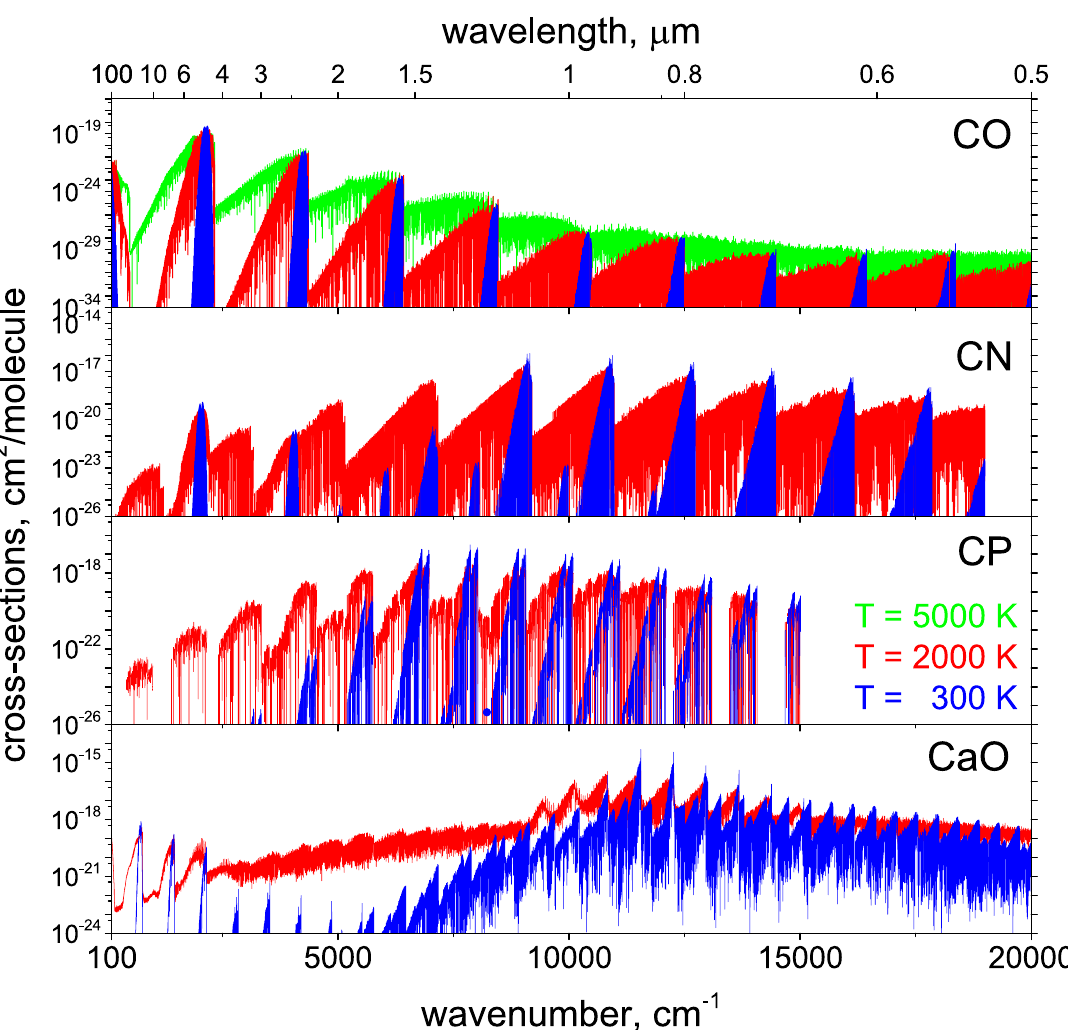
Figure 10. Cross sections for carbon monoxide, cyanide, carbon phosphide and calcium oxide. The CN [84] and CP [85] cross sections are based on empirical line lists from the Bernath group. The CaO data are taken from an ExoMol line list [62]. The CO [8] line list is based on an empirical dipole moment